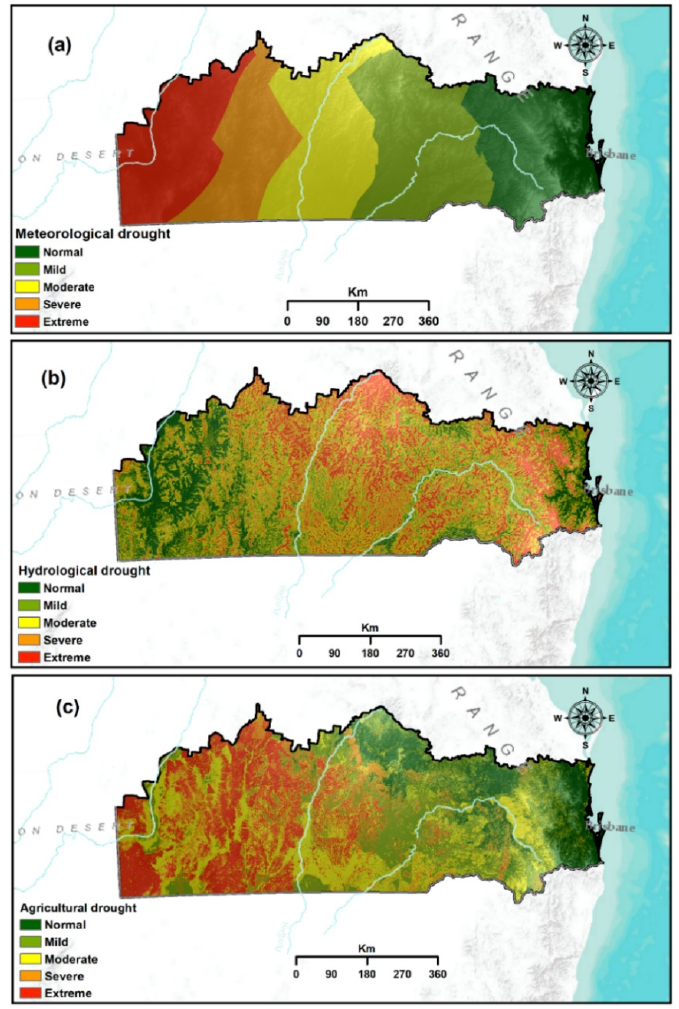
Figure 6. Overall vulnerability map indicating the spatial footprint and vulnerability to drought: ( a ) meteorological drought; ( b ) hydrological drought; and ( c ) agricultural drought.